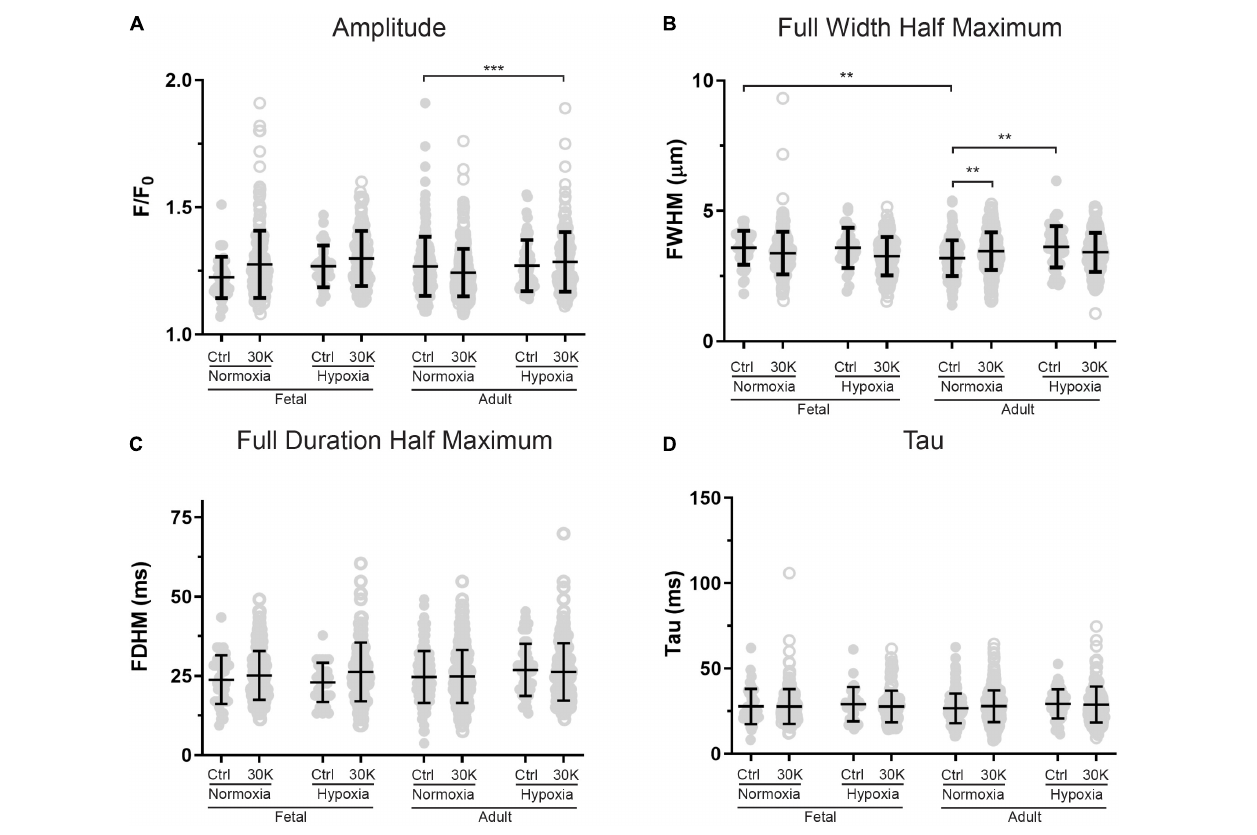
FIGURE 10 | Magnitude and kinetics of Ca 2 + sparks were minimally influenced by animal age, LTH, or membrane depolarization. (A–D) amplitude, full width at half-maximum, full duration at half-maximum and tau exposed to control (closed circles) or 30 K (open circles) for Ca 2 + spark events of arterial myocytes from adult and fetal sheep under normoxic and hypoxic conditions. Bars represent means ± SD for each parameter. Data were analyzed by a Kruskal–Wallis one-way ANOVA with Dunn’s multiple comparison test based on ranks for each group ** P < 0.01, *** P < 0.001. Recordings were made in FN control (41/161/3) and 30K (199/172/3), FH control (30/171/4) and 30K (136/185/4), AN control (173/150/3) and 30K (365/155/3), and AH control (52/207/4) and 30K (177/217/4) Ca 2 + sparks/lines/animals,